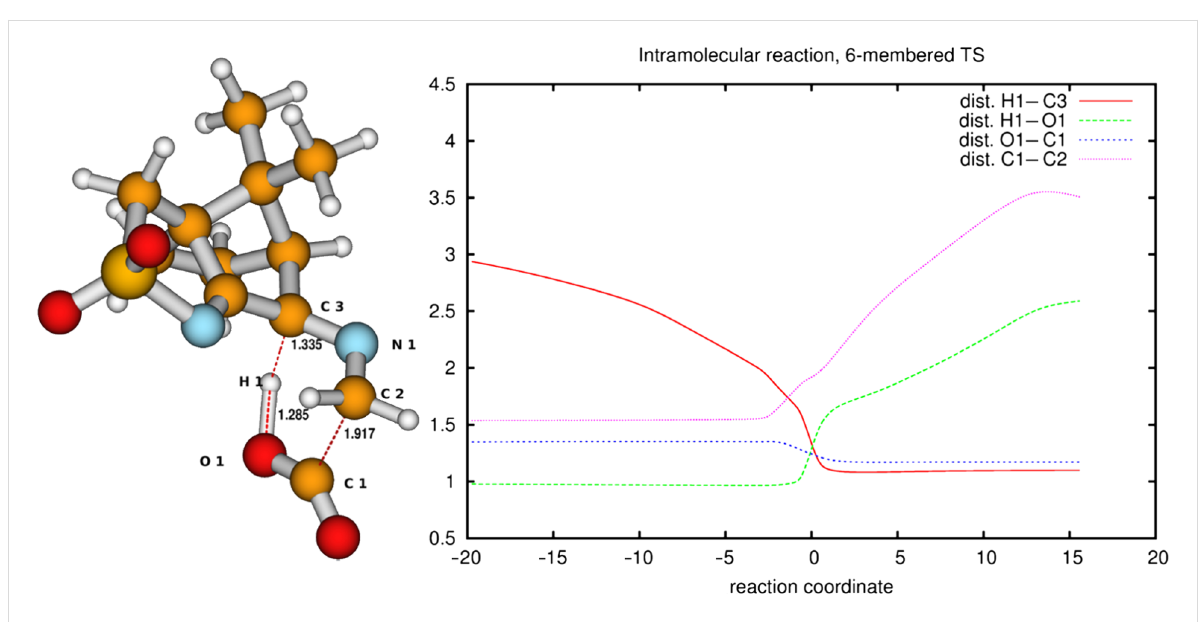
Figure 9: Transition-state geometry and salient bond distances along the IRC path for the reaction of 6g → 11 . The mass-weighted intrinsic reaction coordinate is in the unit amu ½ *bohr.